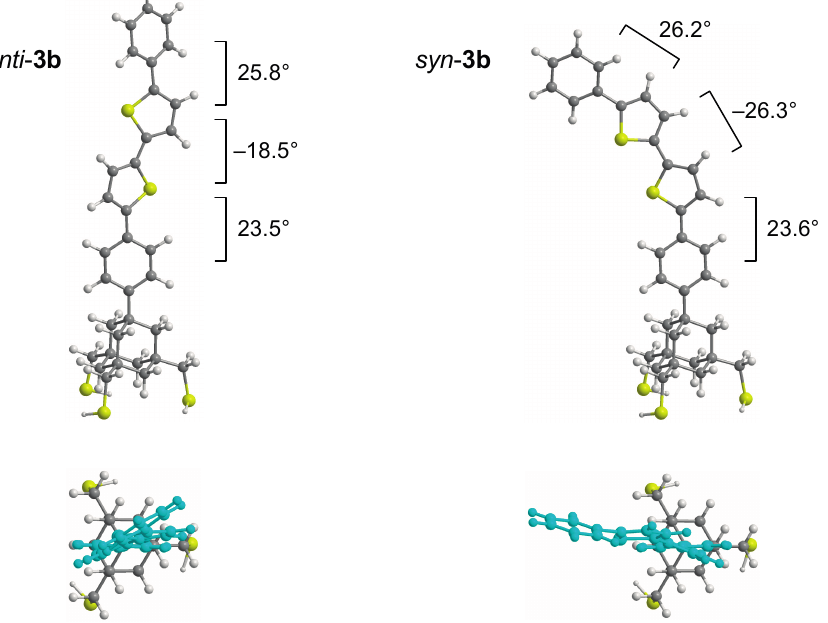
Figure 5. DFT-optimized structures of anti and syn conformers of trithiol 3b calculated at the B3LYP/3-21G(d) level. The dihedral angles between adjacent rings are shown. Lower structures represent top views, with the diphenylbithiophene moiety highlighted in light